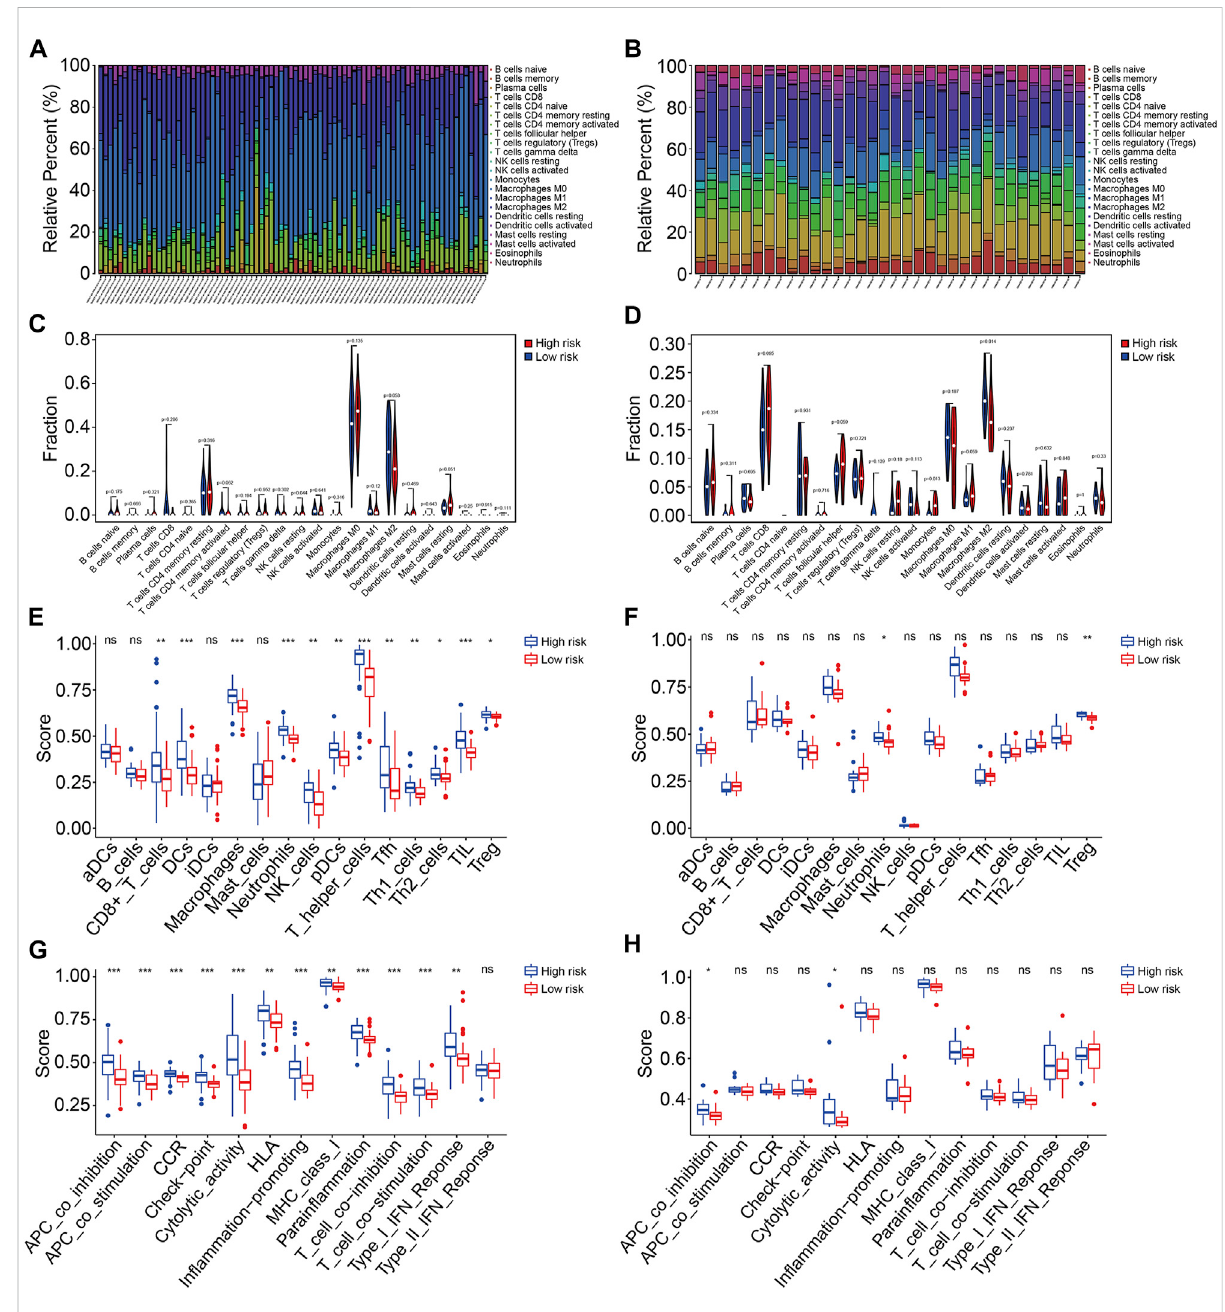
FIGURE 9 TheTMEMproteinfamilygene-basedsignaturewascorrelatedwiththetumorimmunemicroenvironment. (A,B) Distributionof22immunecell types in fi ltratedinosteosarcomasamplesoftheTCGA andGSE16091 cohort. (C,D) Comparisonofthein fi ltrated immune cellsinthehigh- andlow- risk groups of the TCGA and the GSE16091 cohort. (E,F) Enrichment scores for the immune cell were compared between the high- and low-risk groups in the TCGA and GSE16091 cohorts. (G,H) Enrichment scores for the related-immune function were compared between the high- and low-risk groups in the TCGA and GSE16091